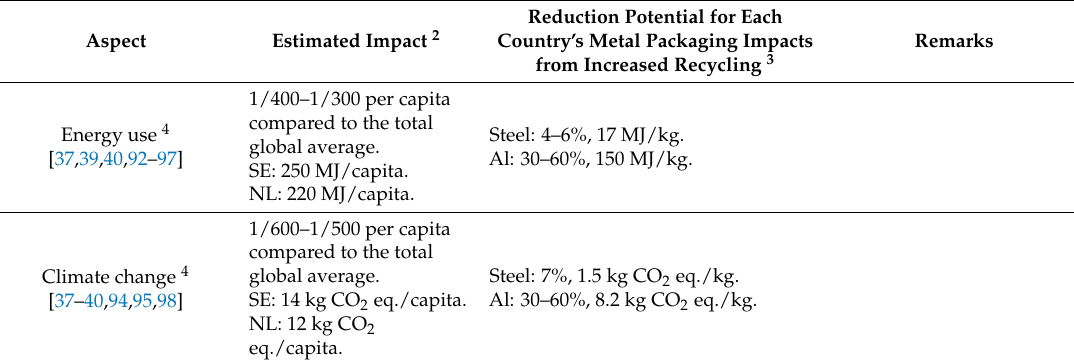
Table 2. Environmental findings on the relation between consumption and recycling of the metal packaging in Sweden (SE) and the Netherlands (NL). Estimates for 2011 and for the potential case of full recycling.